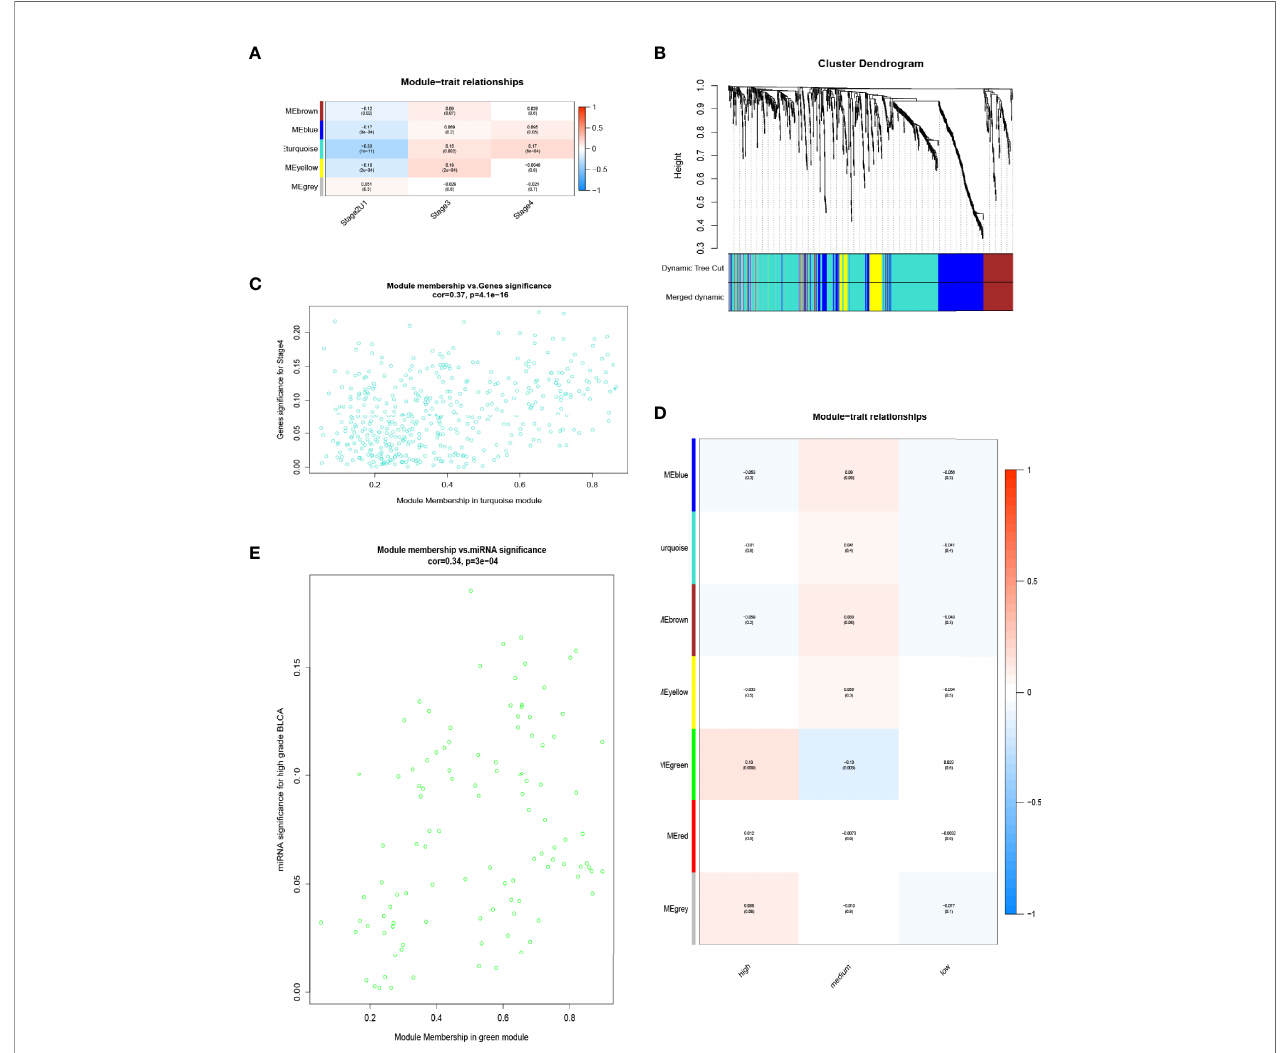
FIGURE 2 | WGCNA was used for DE lncRNAs-mRNAs and miRNAs. (A) Correlation between RNA modules and clinical stage of samples. (B) Dynamic tree-cutting and merging dynamic methods to identify 14 RNA modules. (C) Sucessive analysis of brown mRNA-lncRNA modules with stage IV (cor. = 0.37, P = 4.1e-16). (D) Expression data of miRNAs from GEO-BCa were classi fi ed into three clinical features for WGCNA: high grade (high pathological grade with pathological T-stage ≥ pT2), medium grade (high pathological grade with pathological T-stage < pT2) and low grade (low pathological grade). (E) Correlation between green module (108 miRNAs) and high